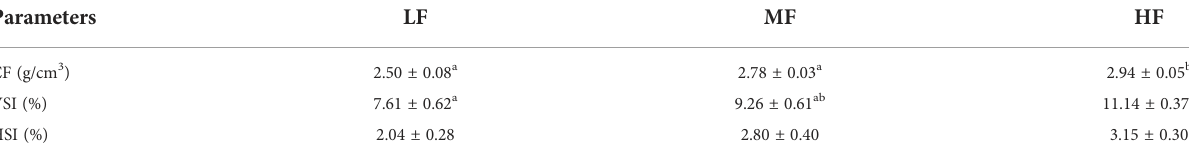
TABLE 4 Effect of dietary lipid levels on morphological indexes of hybrid grouper.